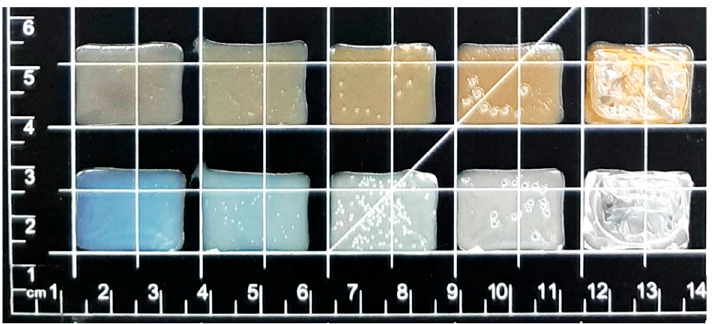
Figure 9. Pictures of drug-loaded films with liver powder (upper row) and drug-loaded films (lower row). From the left, after drying at room temperature, 40, 60, 80, and 100 °C.